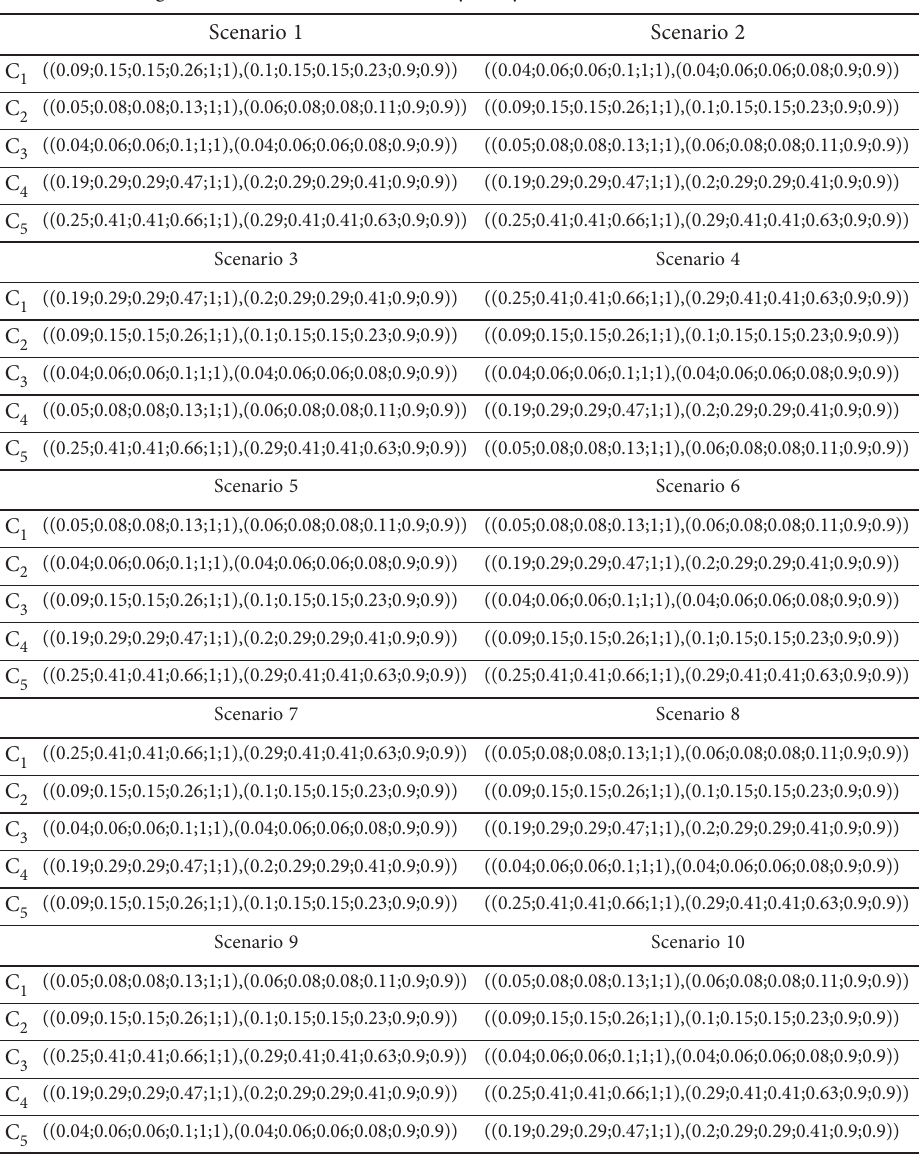
Table 11. The weights of main criteria for sensitivity analysis of scenarios Scenario